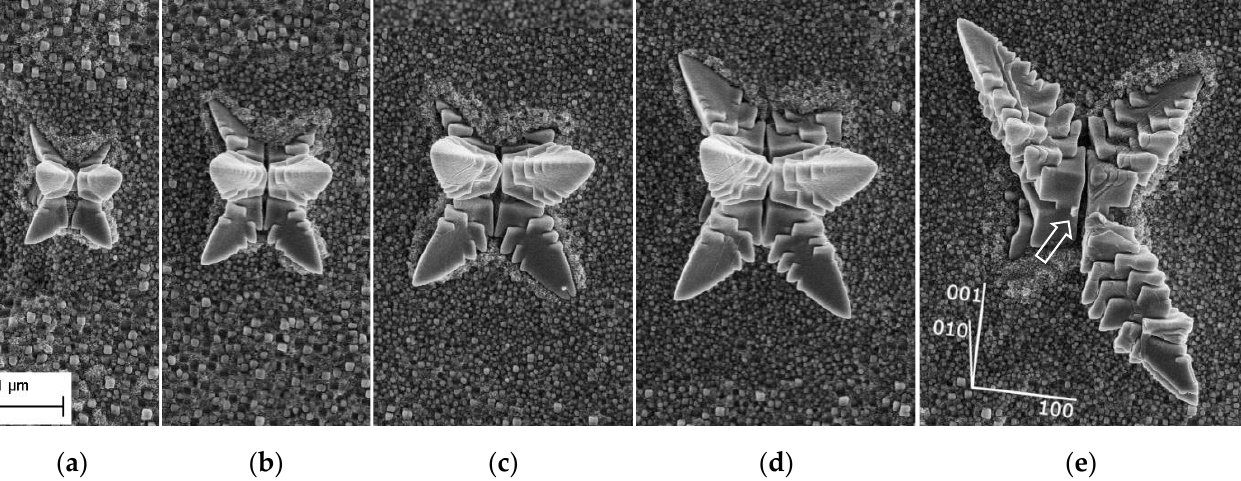
Figure 2. γ’ -precipitates of different sizes after cooling to 1165 °C (deep etched specimen). Based on this sequence, the morphology change during the early stages of growth can be demonstrated. ( a ) Division in octocube already occurred, cube corners stretched in <111>-directions, first signs of steps at edges of stretched corners. ( b ) Particles grew as a whole (including the central octocube), number and size of steps at edges increased. ( c , d ) Further growth. ( e ) Significantly more pronounced steps, three of eight primary arms are no longer present. The arrow indicates a tiny contact area where the two missing arms seem to have been connected to the two remaining on the left side.